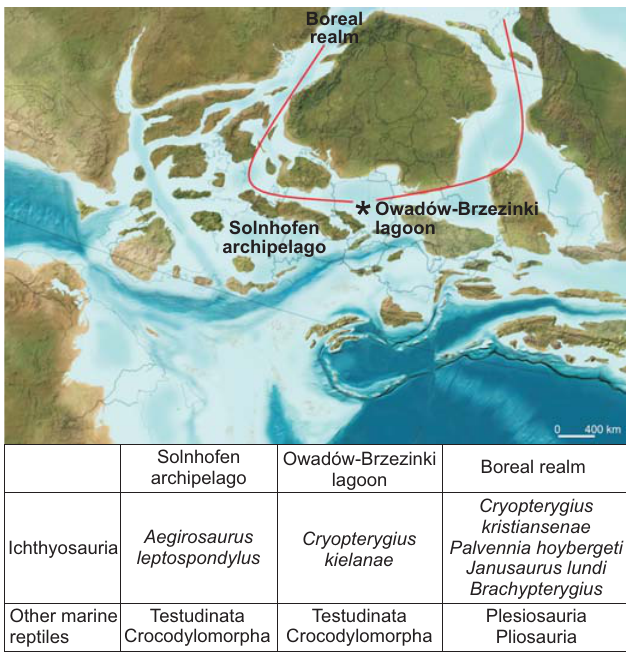
Fig. 10. Palaeobiogeography of the Tithonian marine reptile faunas of Central and North Europe. Red line, the possible migration routes of the boreal ichthyosaurian reptiles. Palaeogeographical map from Ron Blakey, Colorado Plateau Geosystems, Arizona, USA (http://cpgeosystems.com/